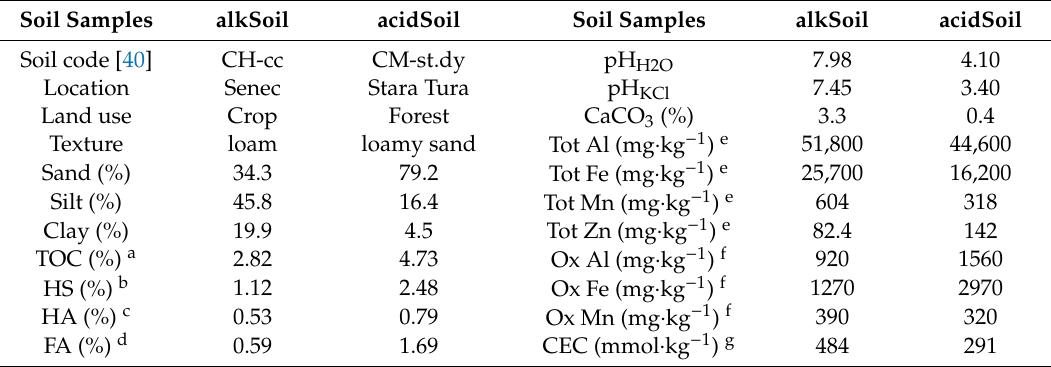
Table 1. Characteristics of soil samples used in sorption